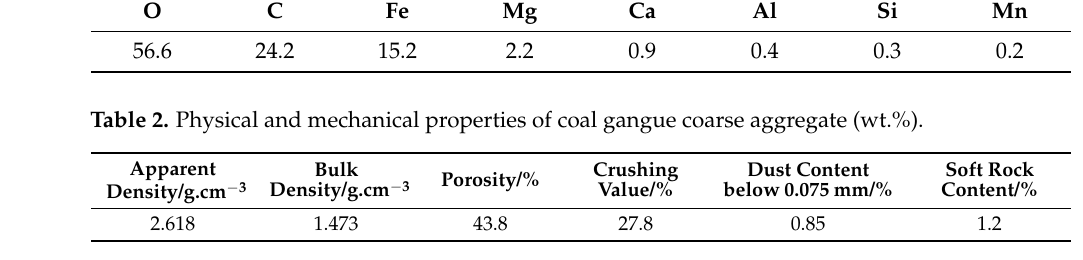
Table 3. Physical and mechanical properties of coal gangue fine aggregate (wt.%). Apparent Densi- ty/g.cm − 3